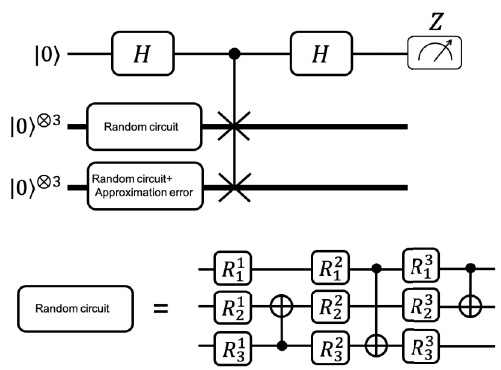
FIG. 7. Schematic figure of simulated seven-qubit SWAP test circuit. We calculate the overlap of randomly generated states and the approximation of the generated state by using the Solovay-Kitaev algorithm. The random circuit is composed of three layers, each of which consists of random single-qubit rotation gates and CNOT gates acts on two randomly chosen